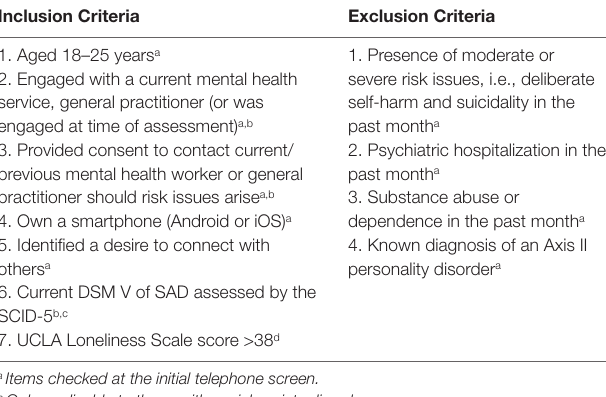
TABLE 2 | Study inclusion and exclusion criteria for social anxiety disorder and student